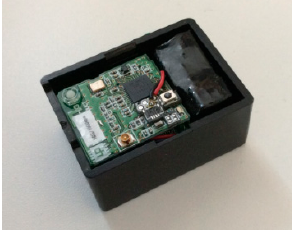
Figure 3. Wearable motion